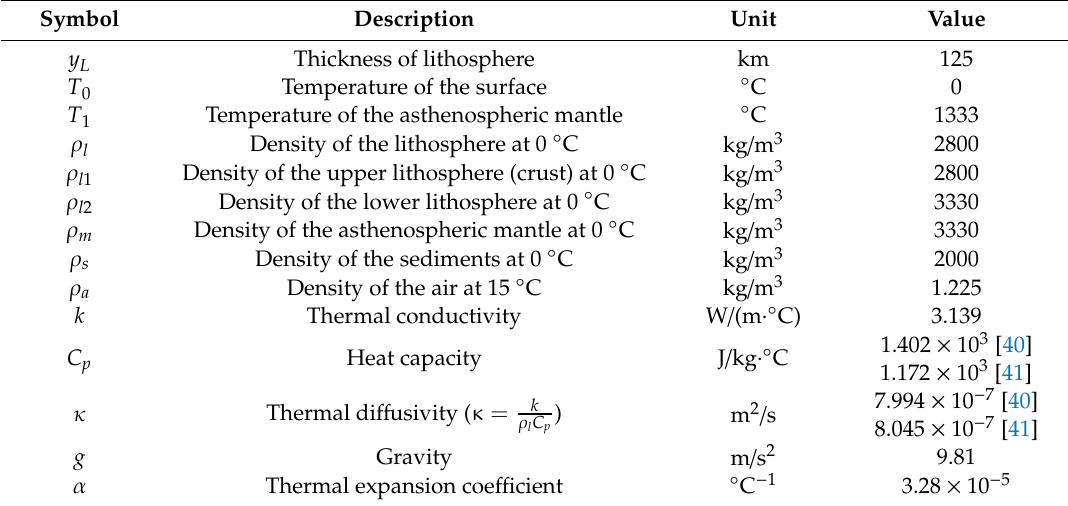
Table 1. Model parameters (after